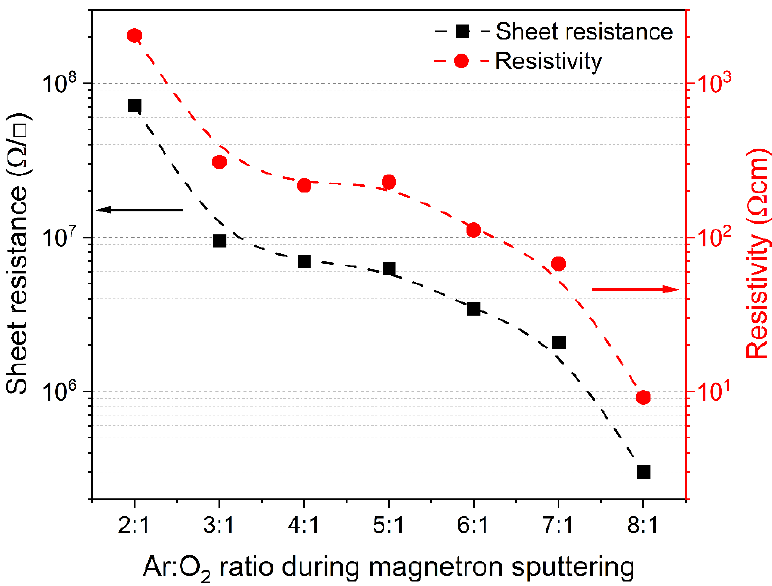
Figure 9. Dependence of sheet resistance and resistivity of vanadium oxide thin films on the Ar:O 2 gas ratio during the preparation